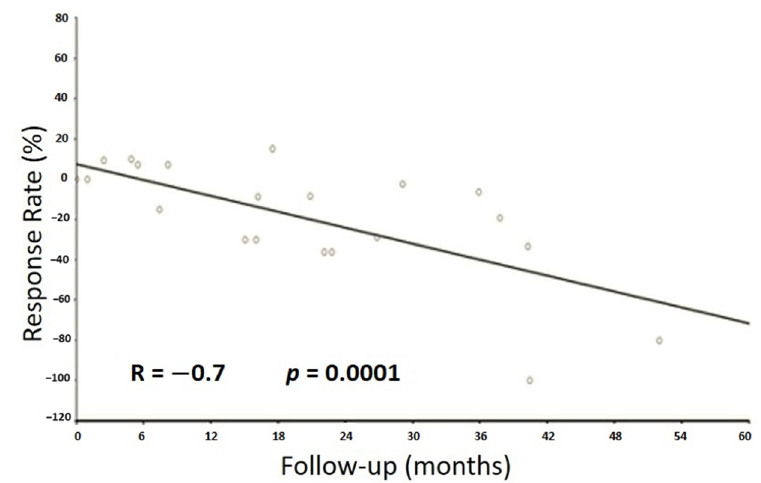
Figure 1. Correlation between tumor size and follow-up.